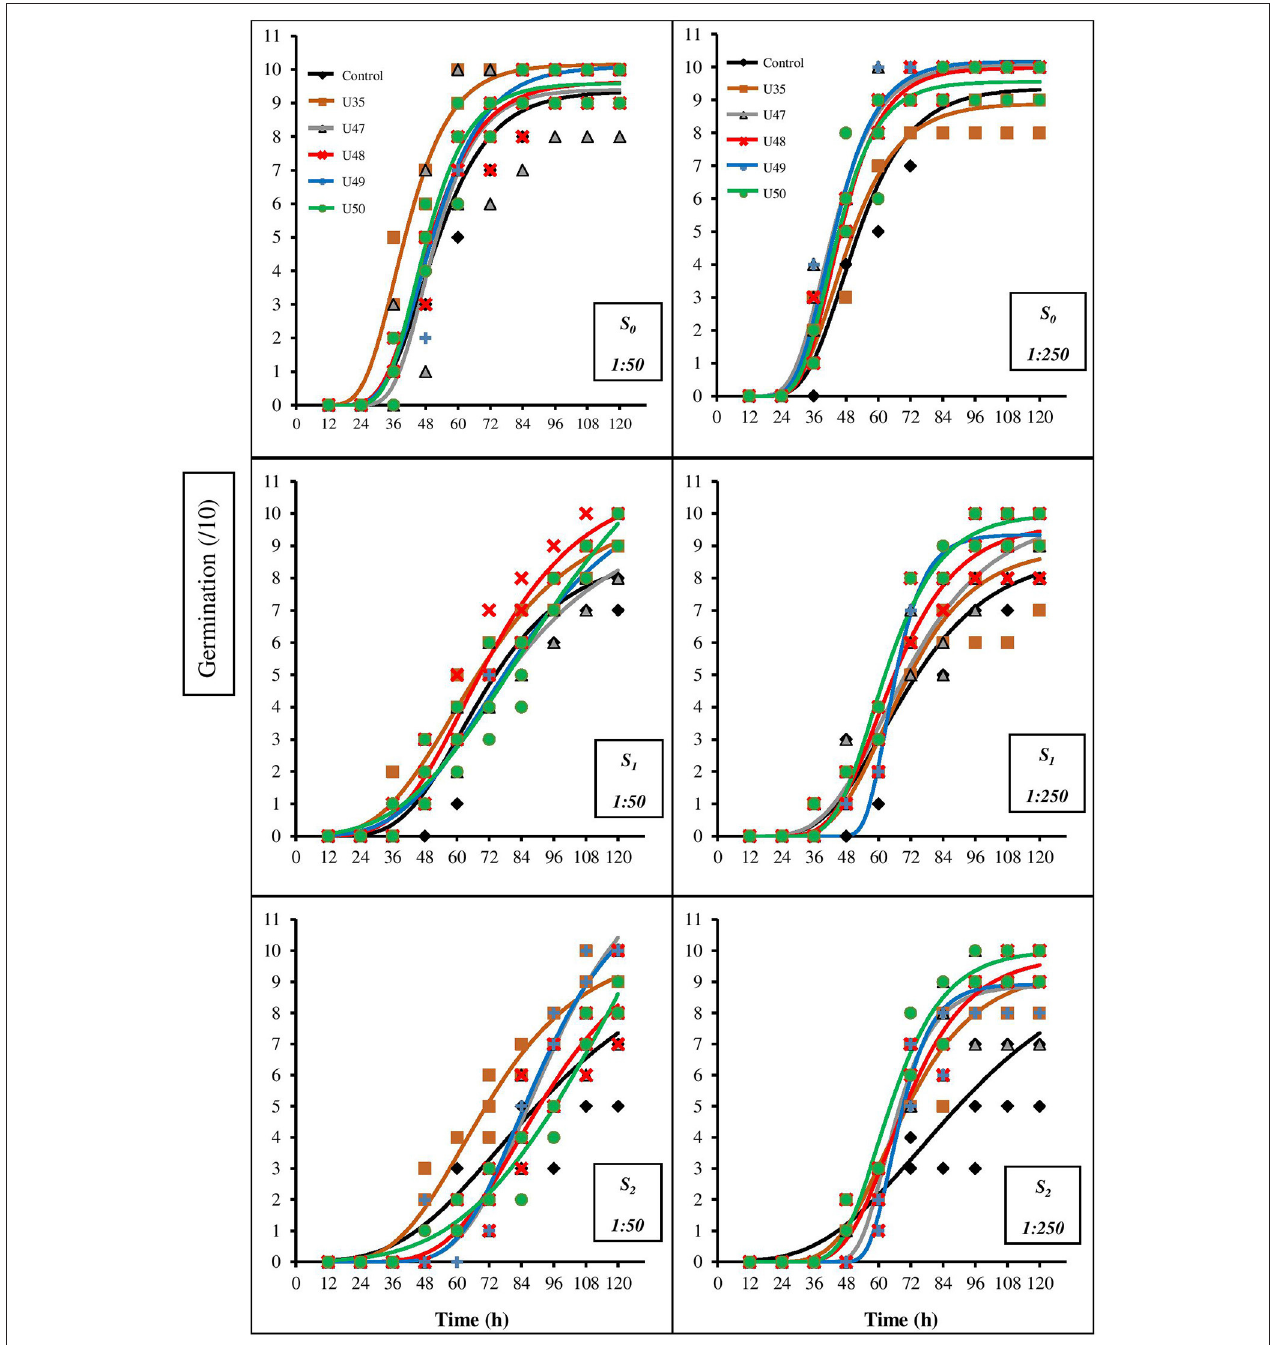
FIGURE 1 | Changes in seed germination percentage for corn in response to salinity (0, 100, and 150mM NaCl) and 1:50 and 1:250 dilutions of Bacillus strain CFSs (U35, 47, 48, 49, and 50). Values represent the means of five replicates ± SD. S 0 , S 1 , and S 2 indicate 0, 100 and 150mM NaCl, respectively. 1:50 dilution = 1mL CFS of each Bacillus strain in 50mL distilled water and 1:250 dilution = 1mL cell-free supernatant of each Bacillus strain in 250mL distilled